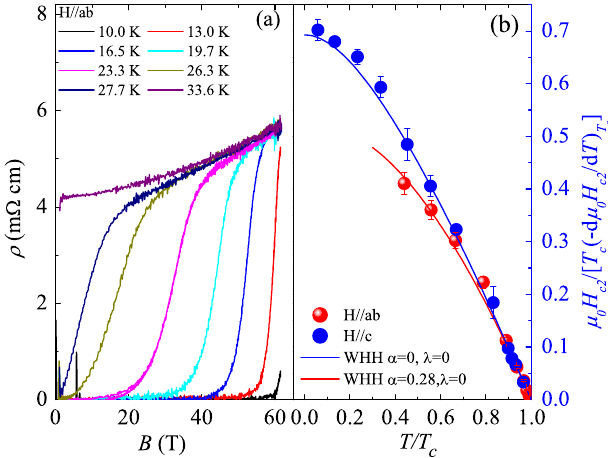
FIG. 3. The upper critical fields in K 0 Fe 1 Se 1 Te 0 . 70 . 46 . 85 . 15 follow the temperature dependence as predicted by the WHH theory. (a) Field dependence of the in-plane resistivity of K 0 Fe 1 Se 1 Te 0 for pulsed magnetic fields applied . 70 . 46 . 85 . 15 perpendicular to the c axis. (b) Temperature dependence of the upper critical field H c 2 ð T Þ (plotted as ð μ 0 H c 2 =T c ½ − d μ 0 H c 2 = dT (cid:1) Þ ) for magnetic fields parallel (circles) and perpendicular T c (balls) to the c axis, respectively. The solid lines are the fitting results using WHH theory with different Fig. 3(b)]. Hence, the isovalent Te substitution suppresses